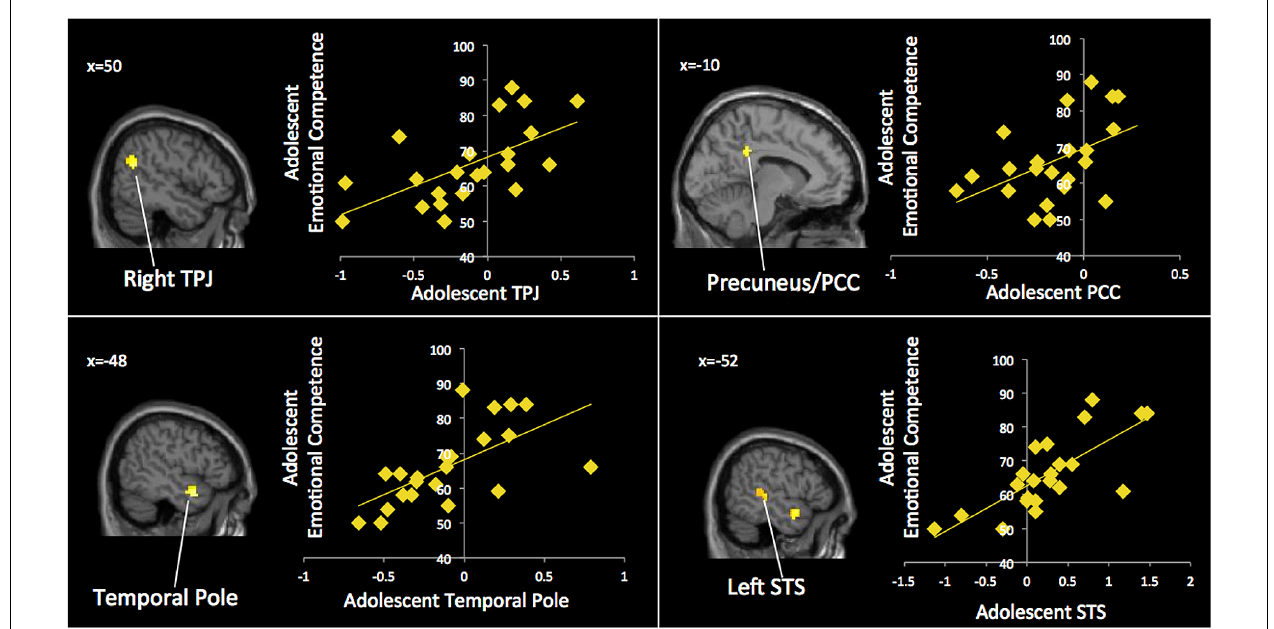
FIGURE 4 |Adolescents’ neural activation is associated with adolescents’ emotional competence.